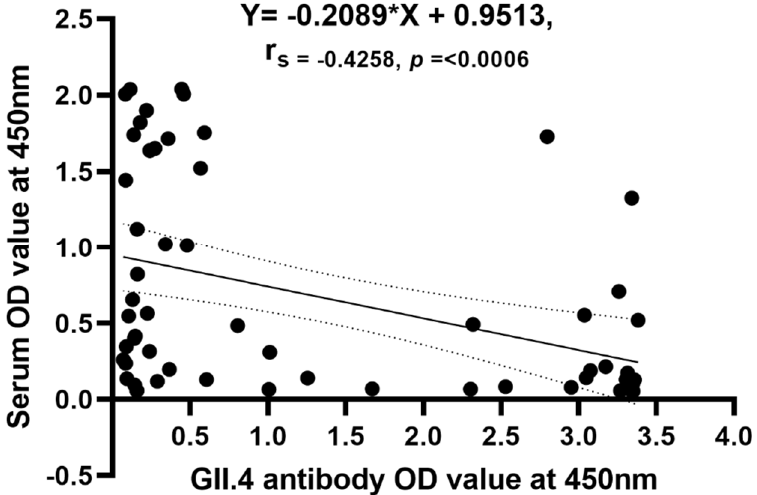
Figure 4. Correlation of antigenemia to serum acute antibody titers.